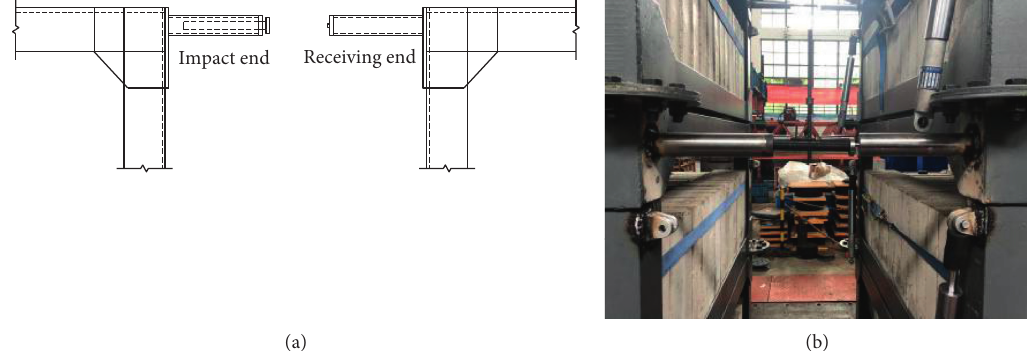
Figure 9: Pounding end design. (a) Diagram of the pounding element. (b) Charts of impact elements for the test models.